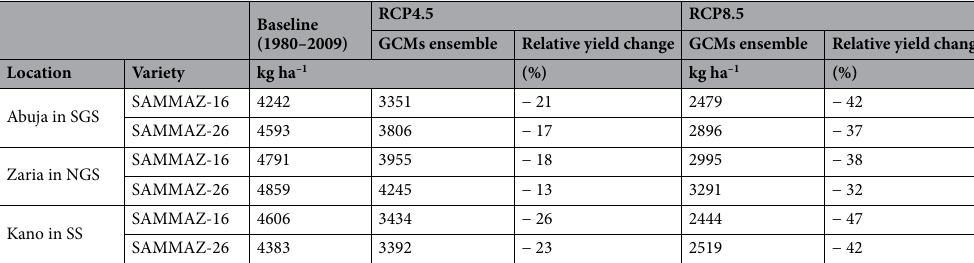
Table 6. Baseline and simulated grain yield (kg ha –1 ) of different maize varieties and the relative yield change (%) at end-century in three agro-ecologies of